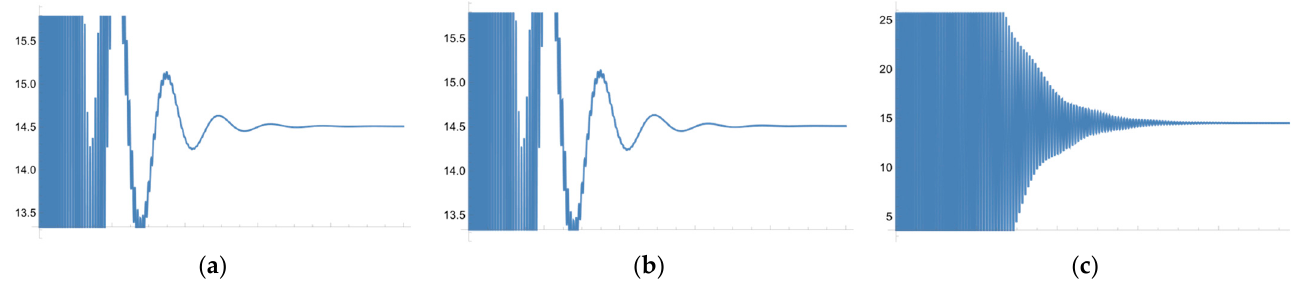
Figure 4. No. 1 state variable I dc ( t ) solved from the 3 models. ( a ) Result from the proposed method, ( b ) Result from the original precise model. ( c ) Result from the traditional singular perturbation.